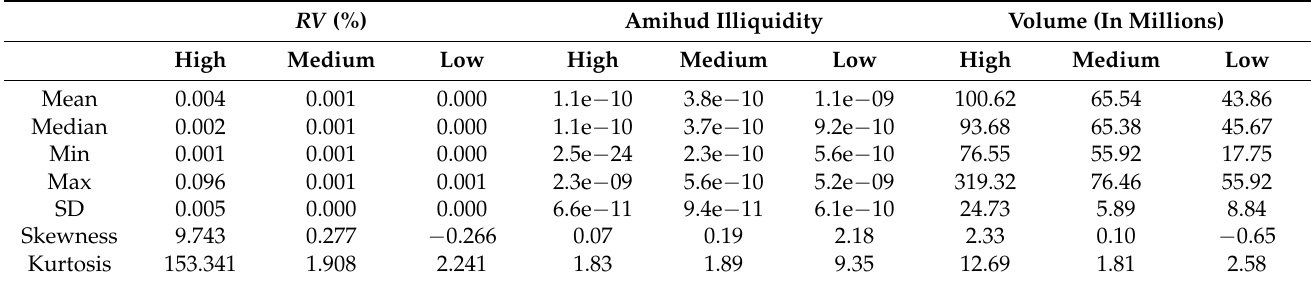
Table 2. Summary statistics of RV, Amihud illiquidity and trading volume for the first 30 min of a trading day.